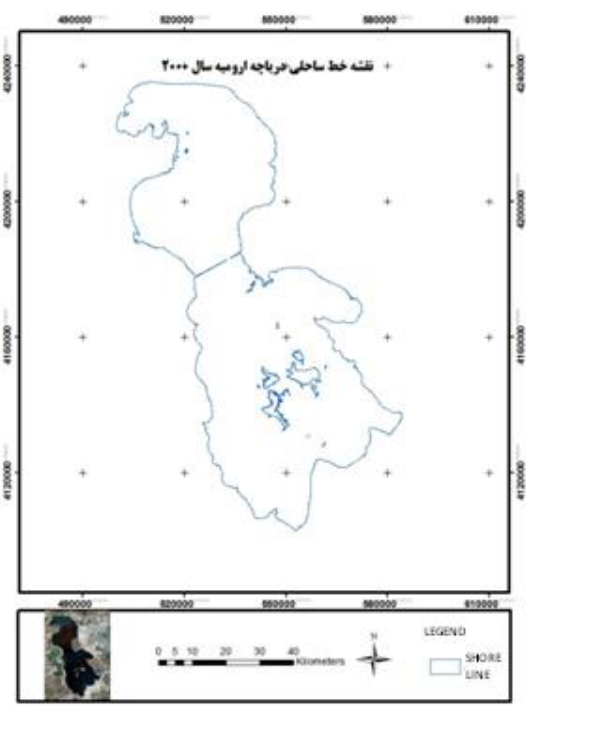
Figure 14: Urmia lake shoreline in 2007